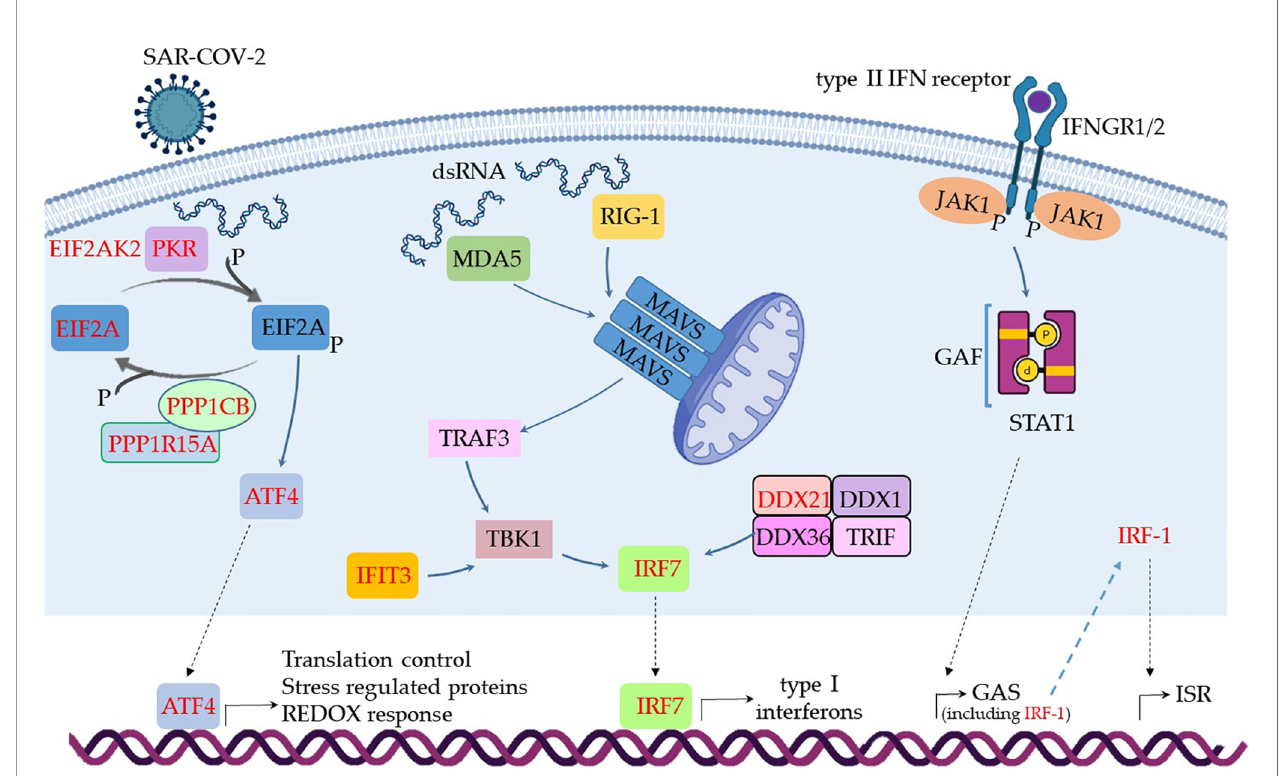
FIGURE 4 | Assumed biochemical pathways involved in virus sensing and antivirus response. The analysis of SARS-CoV-2 DAMPs recognition and antivirus response of MSCs was aligned in a cellular biological condition. The upregulated genes are assigned in red, and the genes expressed at a similar level comparing the group of patients with severe over patients with mild symptoms are indicated in